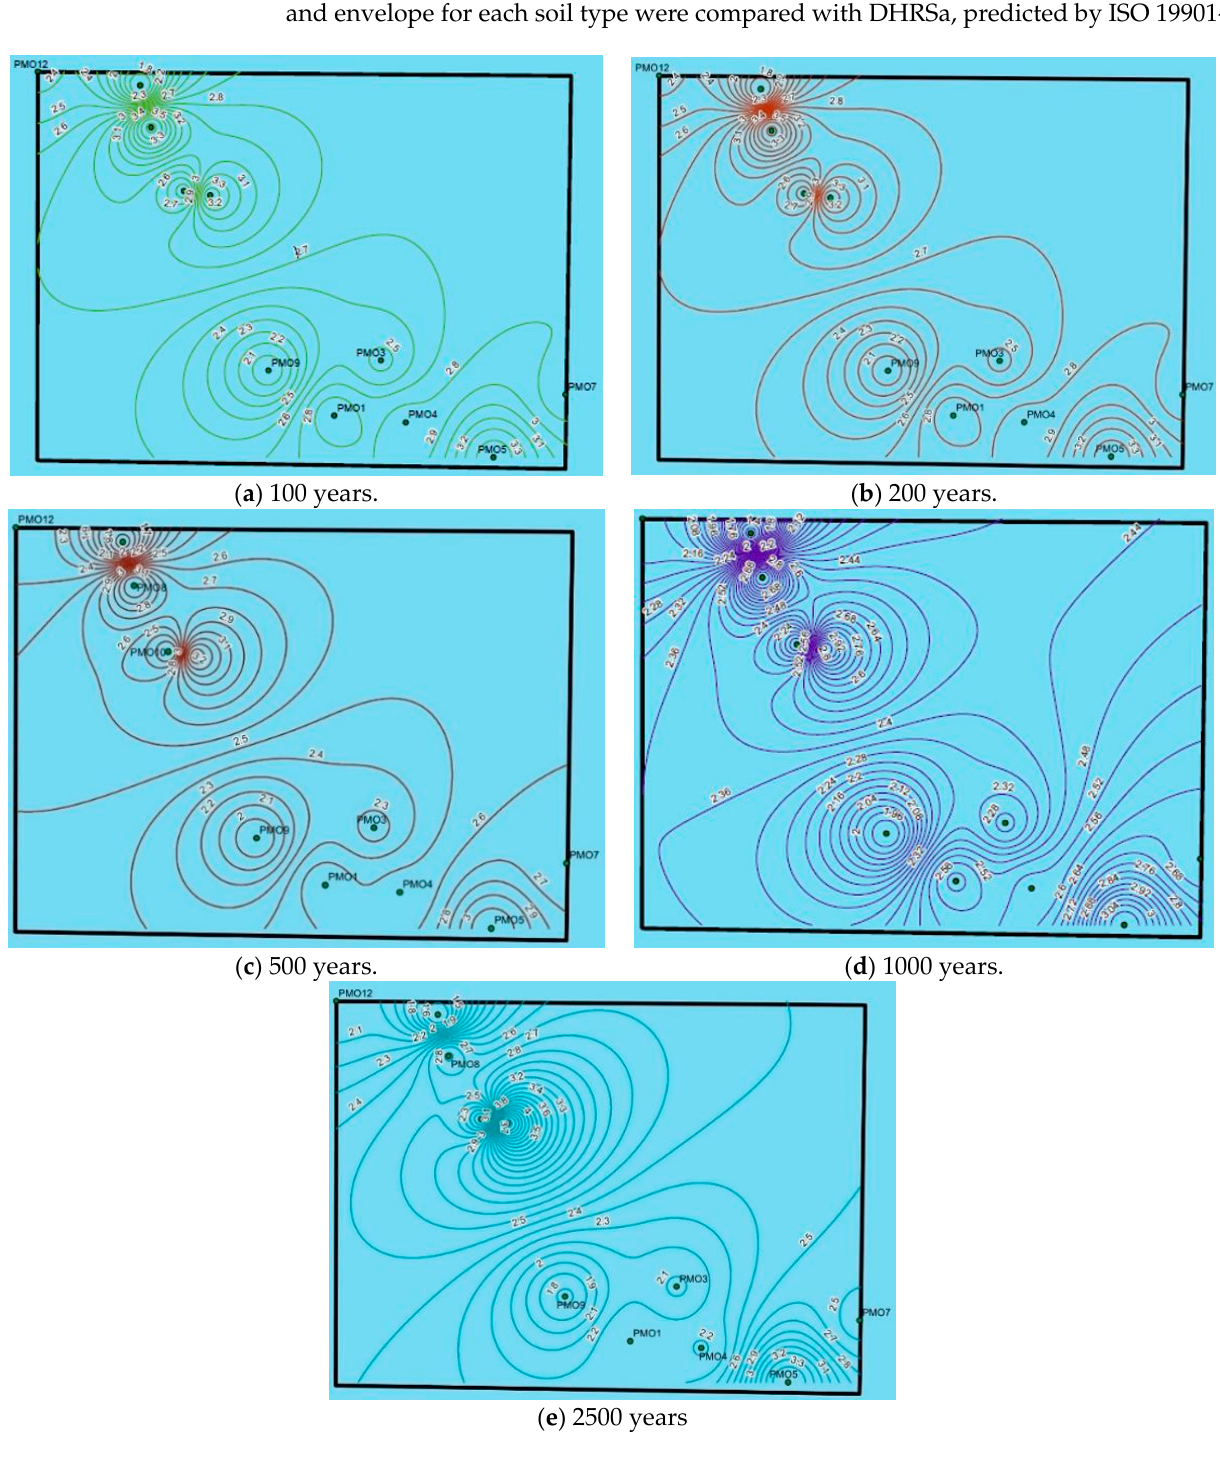
Figure 12. Map of the soil amplification factor for the 200-year return period.